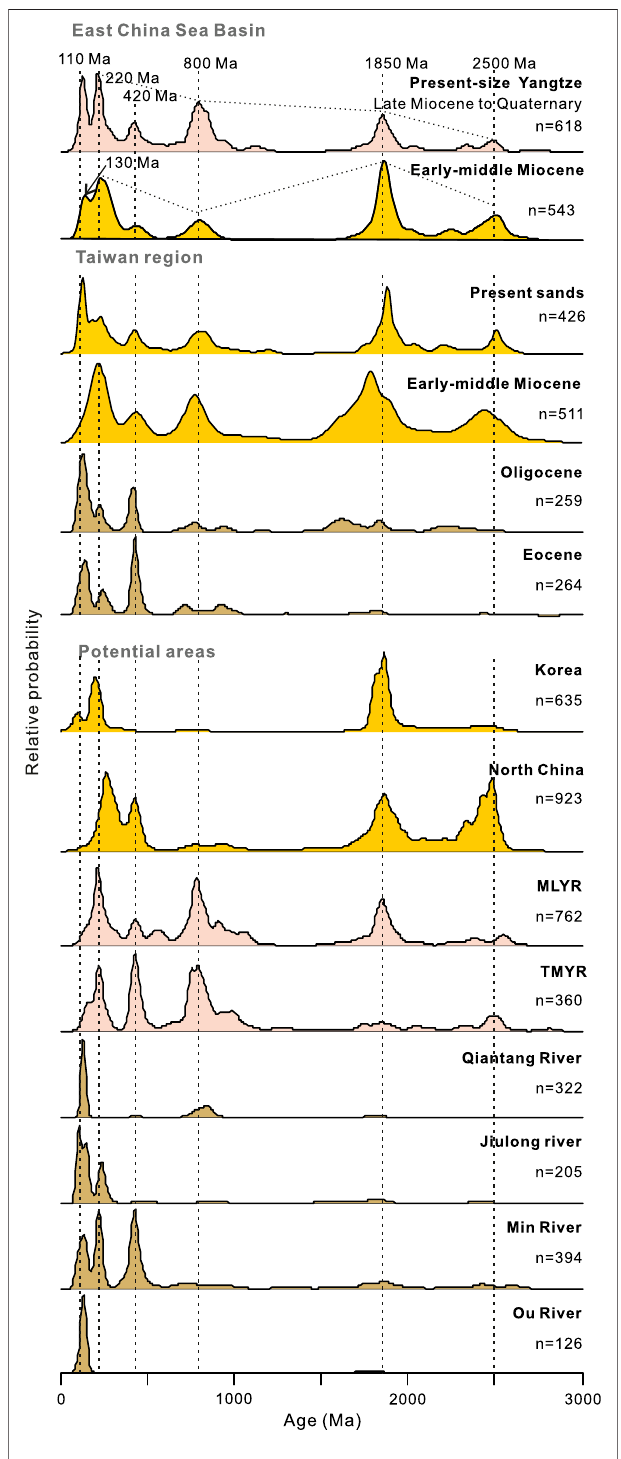
FIGURE 2 | Spectra of detrital zircon ages from the ECSB, Taiwan, and potential areas. The provenance package in R (Vermeesch et al., 2016) was used to make the KDE plots (bin = 20). See Table 1 for source of literature data. MLYR, middle and lower reaches of the Yangtze River trunk stream; TMYR, tributaries in the middle reaches of the Yangtze